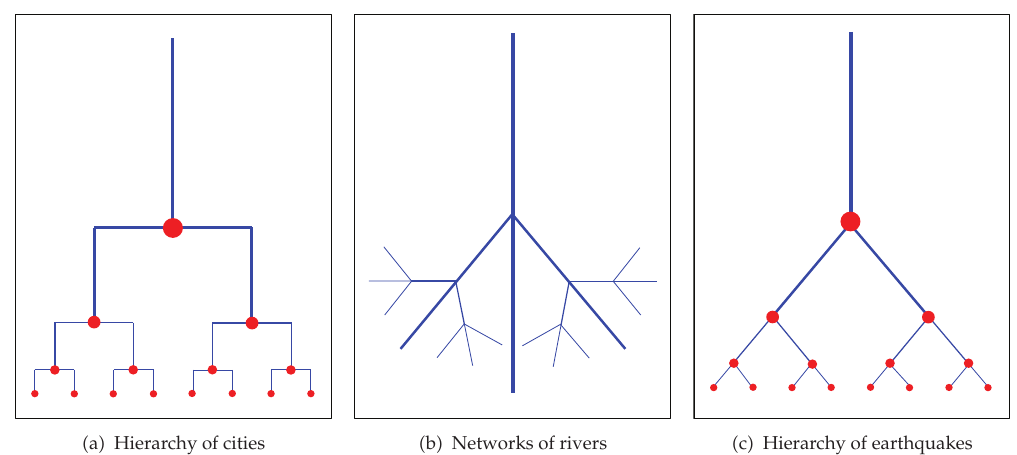
Figure 1: The models of hierarchies of cities, rivers, and earthquakes with cascade structure. (cid:6) Note: the sketch maps only show the first four classes for the top-down models, or the last four classes for the bottom-up models. (cid:7)